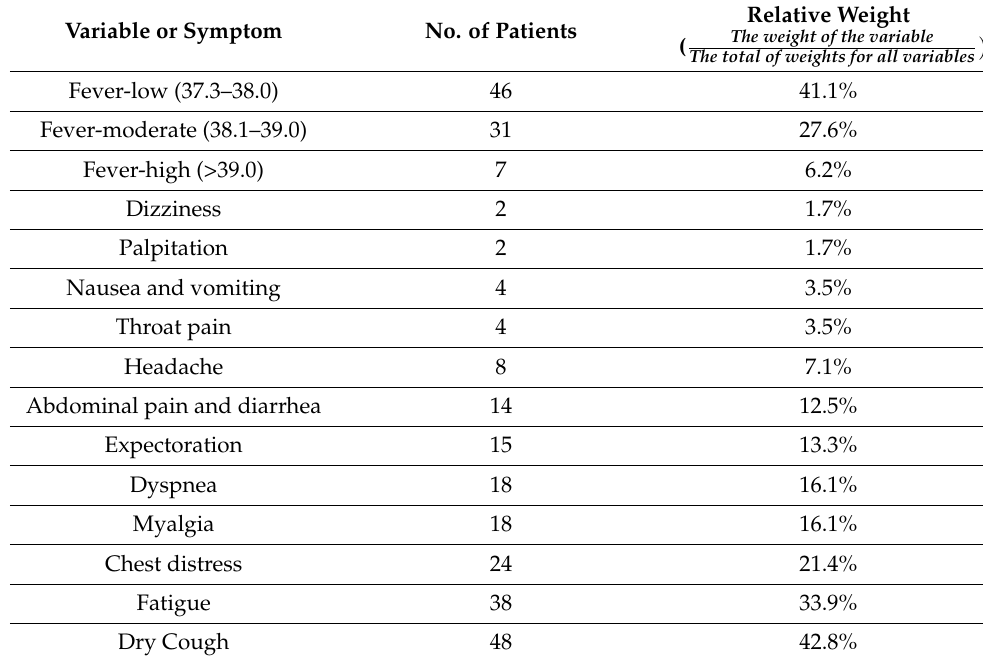
Table 3. The counting dataset for COVID-19 patients who have at most 13 symptoms [36].